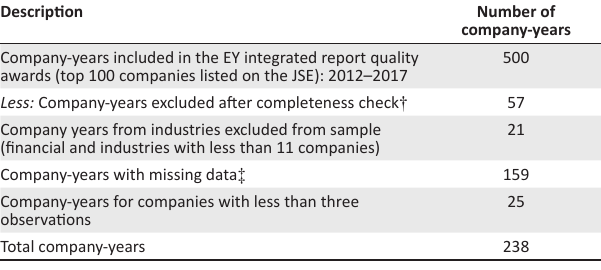
TABLE 1: Sample selection.